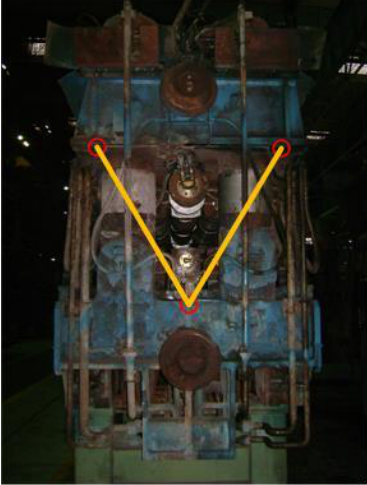
Figure 10. Diagram of three frame-offset wireless sensors.